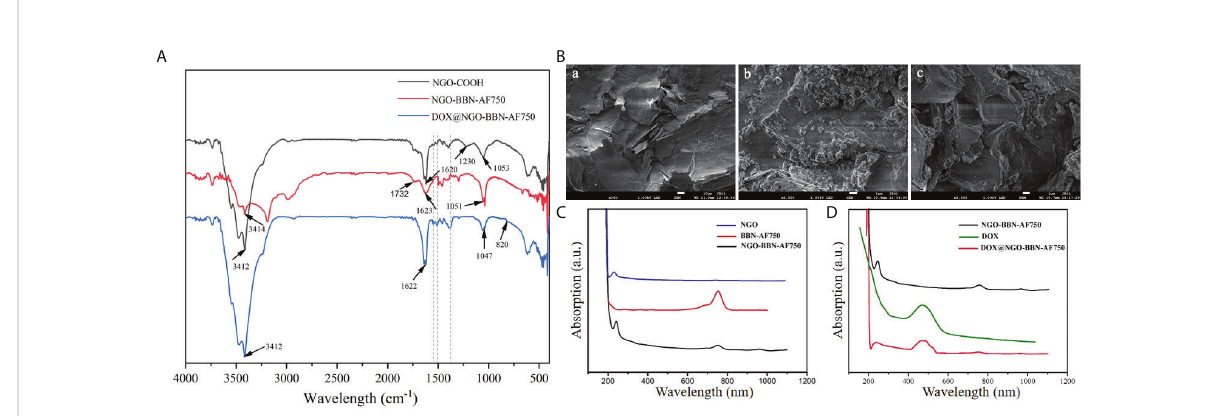
FIGURE 1 Characterizations of the nanoprobes. (A) Fourier transform infrared (FT-IR) spectroscopy of NGO-COOH, NGO-BBN-AF750, and DOX@NGO- BBN-AF750. (B) SEM images of NGO (a), BBN-AF750 (b), and DOX@ NGO-BBN-AF750 (c). Scale bars: 10 µm. (C) UV – Vis spectra of NGO, BBN- AF750, and NGO-BBN-AF750. (D) UV – Vis spectra of DOX, NGO-BBN-AF750, and